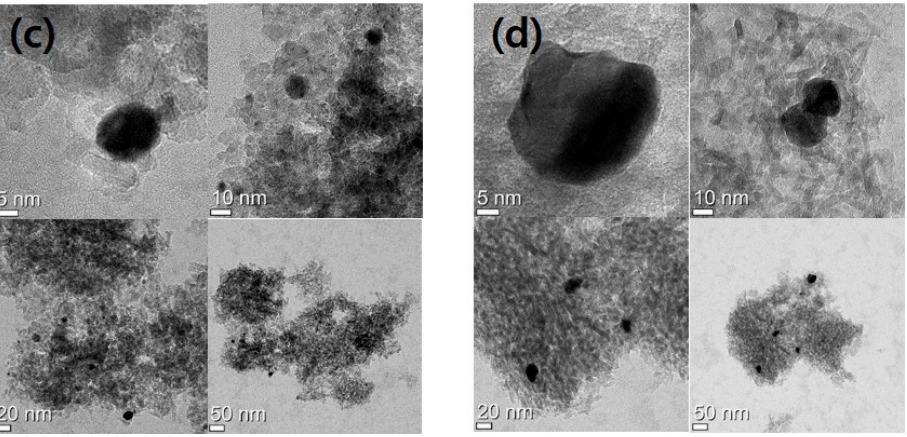
Figure 5. TEM images of ( a ) SR450, ( b ) SR550, ( c ) SR900, and ( d ) Cal600.